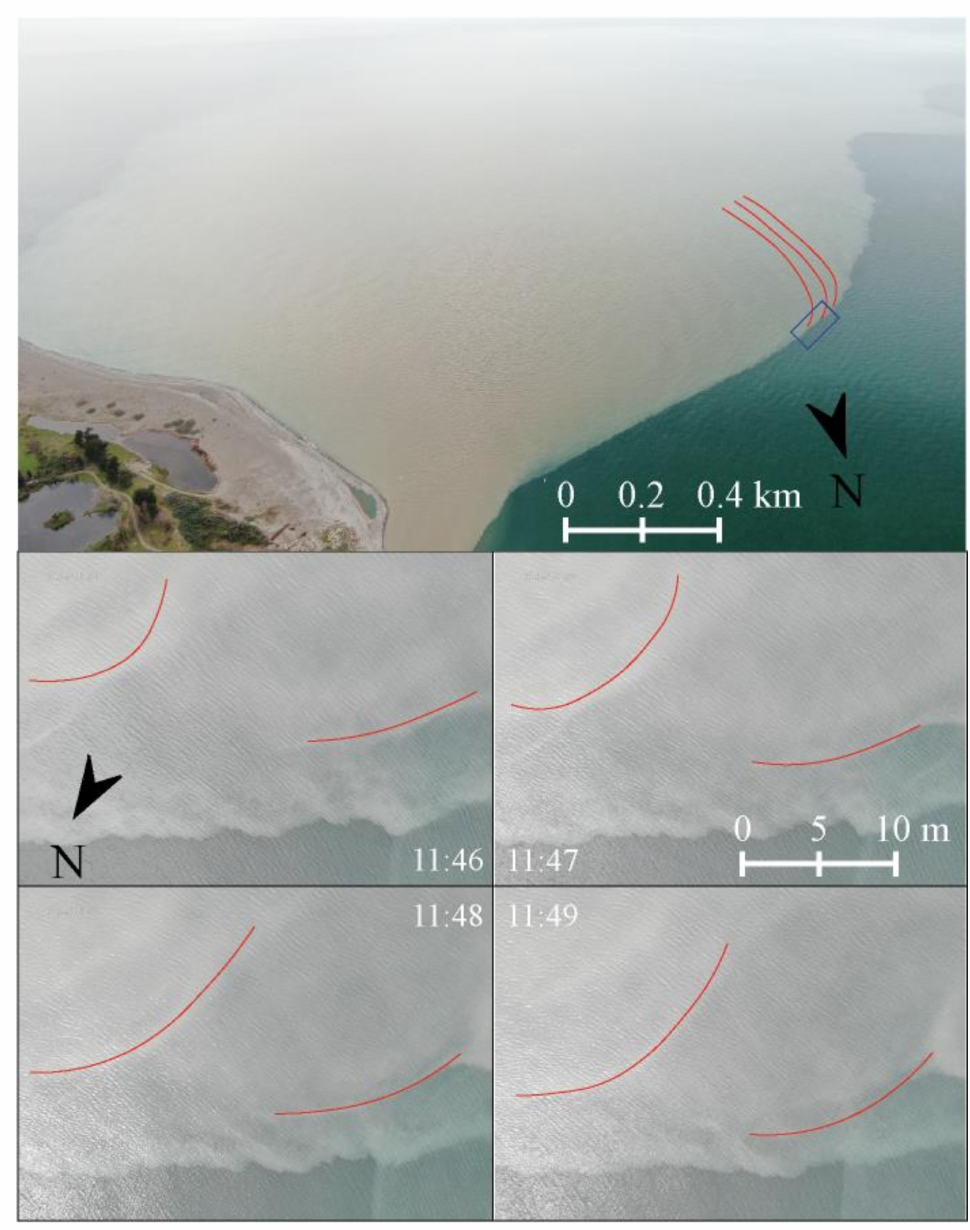
Figure 10. Aerial images of the Bzyb plume on 18 April at 11:46–11:49 illustrating refraction of internal waves (indicated by red lines) at the plume border. The blue rectangle in the top image indicates location of the zoomed-in area in the bottom